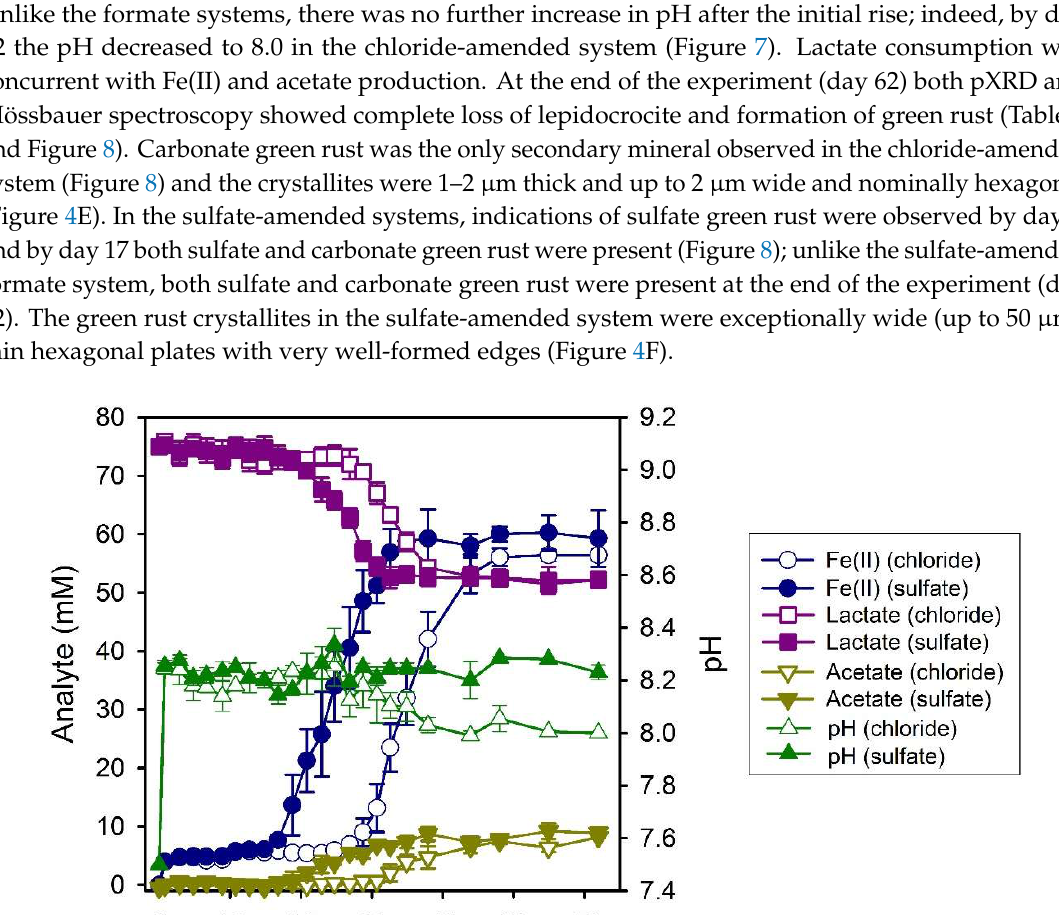
Figure 8. pXRD analysis of the solids in the systems with lactate as the electron donor amended with chloride ( left ) or sulfate ( right ). 3.5. N-Acetylglucosamine (NAG) Within the first 24 h after inoculation, ~3 mM Fe(II) was produced in the chloride-amended system and there was minimal change over the next 24 days (Figure 9). Substantial Fe(II) production was observed between day 25 and day 76 leading to an accumulation of ~61 mM Fe(II) at the